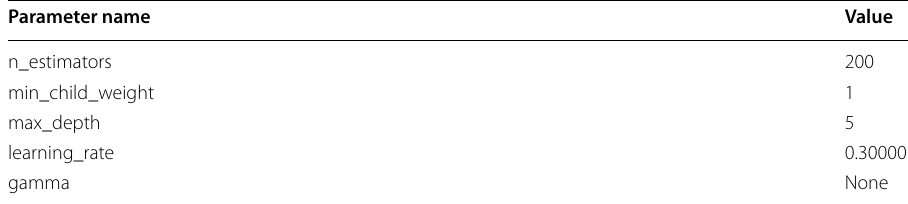
Table 70 Modes of XGBoost tuned hyperparameter values for experiments with the information theft dataset